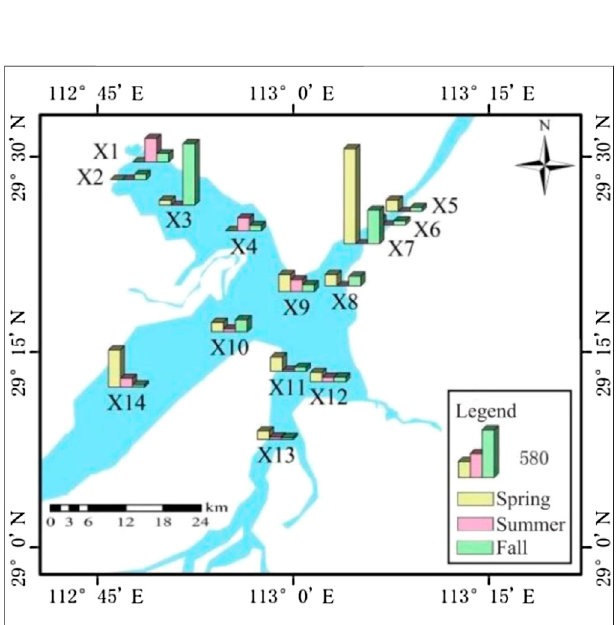
FIGURE 2 | Cumulative concentration of antibiotics in the surface water of East Dongting Lake in different